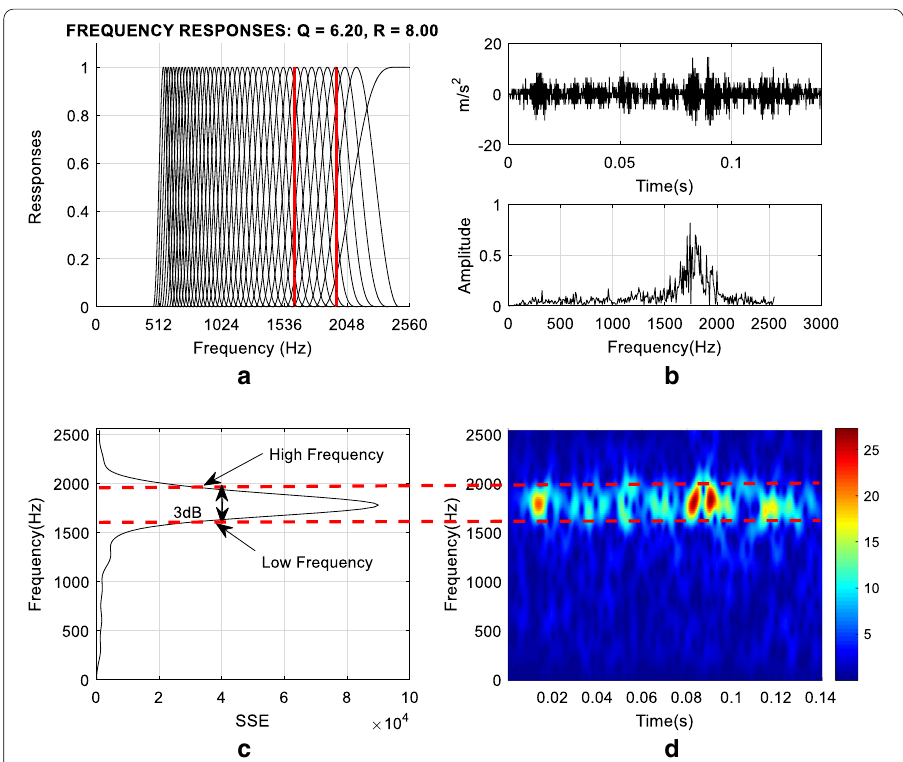
Fig. 10 Schematic diagram of determining the characteristic frequency band by 3 dB bandwidth attenuation method: a frequency response of TQWT; b waveform and spectrum of the simulation signal; c SSE curve; d time–frequency distribution